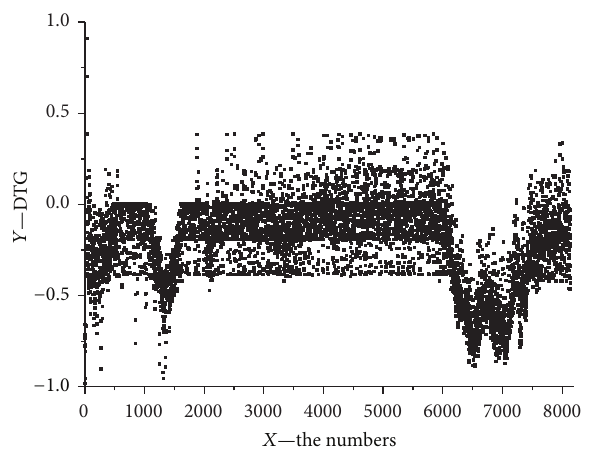
Figure 2: The time series of DTG.